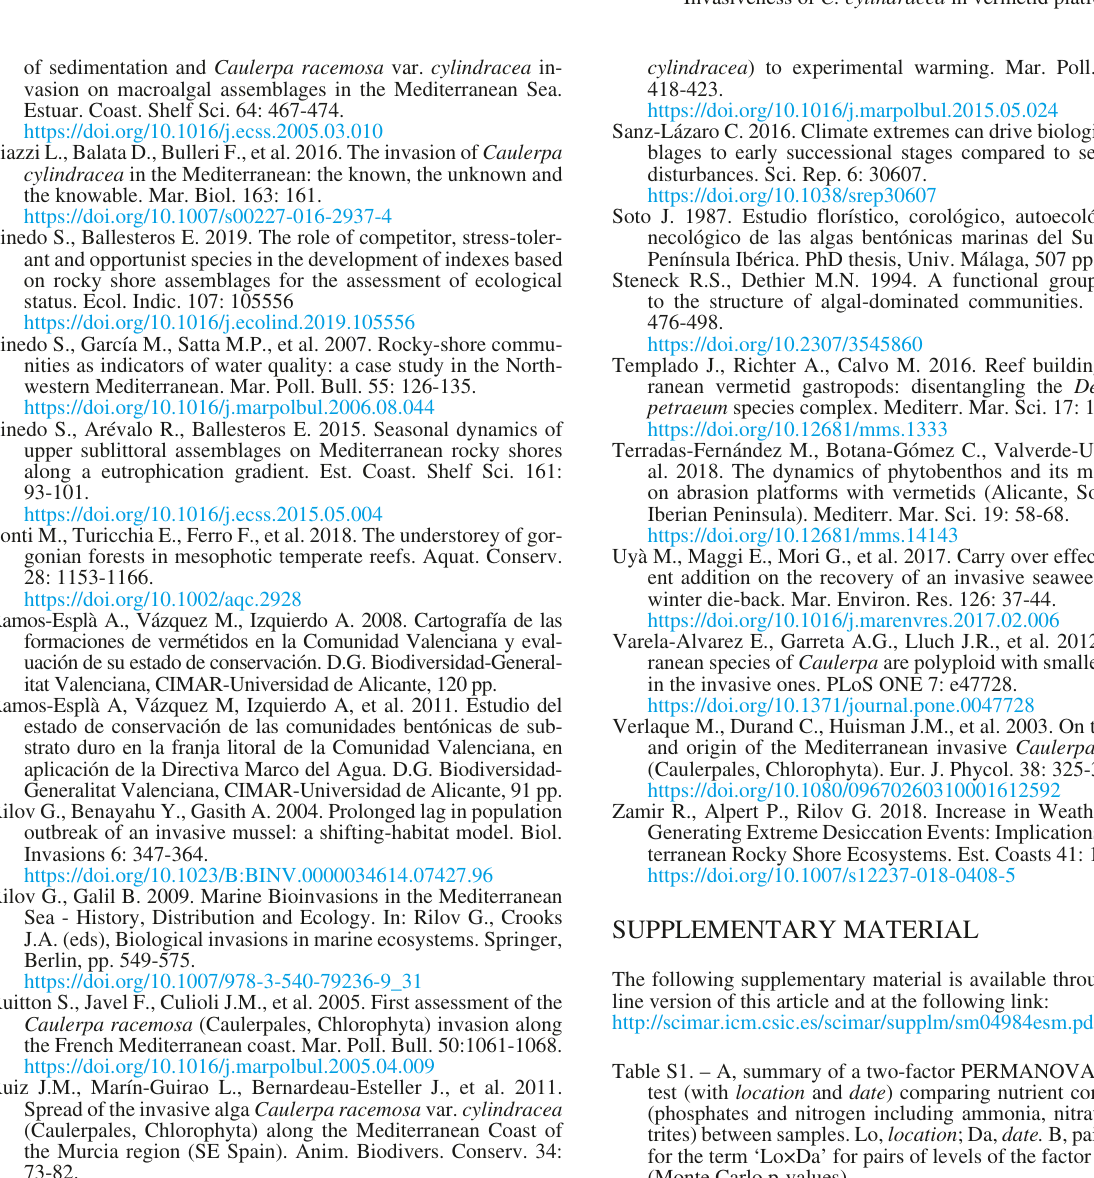
Table S1. – A, summary of a two-factor PERMANOVA univariate test (with location and date ) comparing nutrient concentration (phosphates and nitrogen including ammonia, nitrates and ni- trites) between samples. Lo, location ; Da, date. B, pairwise tests for the term ‘Lo×Da’ for pairs of levels of the factor ‘Location’ (Monte Carlo p-values). Table S2. – A, summary of a four-factor PERMANOVA univariate test (with location, zone, date and site nested in location ) com- paring sediment cover between samples. Lo, location ; Da, date. B, pairwise tests for the term ‘Lo×Zo×Da’ for pairs of levels of the factor ‘Location’ (Monte Carlo